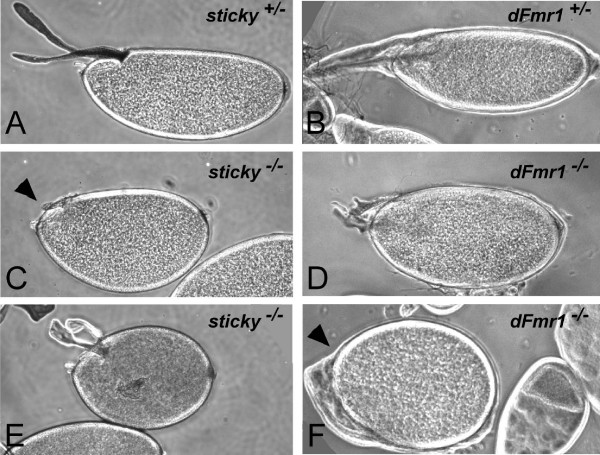
sticky and dFmr1 mutant oocytes exhibit predicted axis polarity defects. (A-B) Phase contrast images of sticky+/- wild-type and dFmr1+/- wild-type, stage 14 oocytes showing normal dorsal/ventral axis formation as well as normal dorsal appendages. (C-E) Stage 14 stickyZ3-5829/sticky3 (sticky-/-) and dFmr13/3 (dFmr1-/-) mutant oocytes are completely ventralized with missing or severely malformed dorsal appendages. Arrowheads point to regions of the oocytes where dorsal appendages would normally emanate.